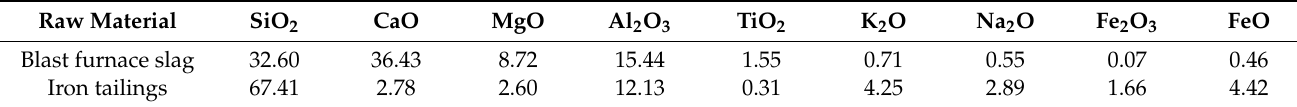
Table 1. Main chemical components of the raw